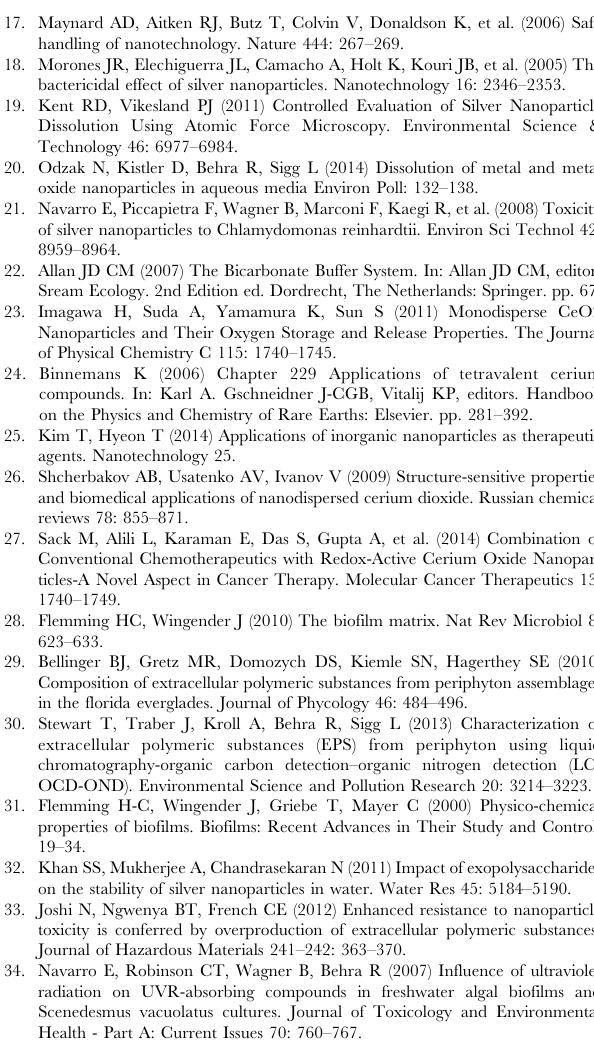
EPM of NP formed in AgNO 3 solutions dependent on pH, light/ dark, EPS content, and